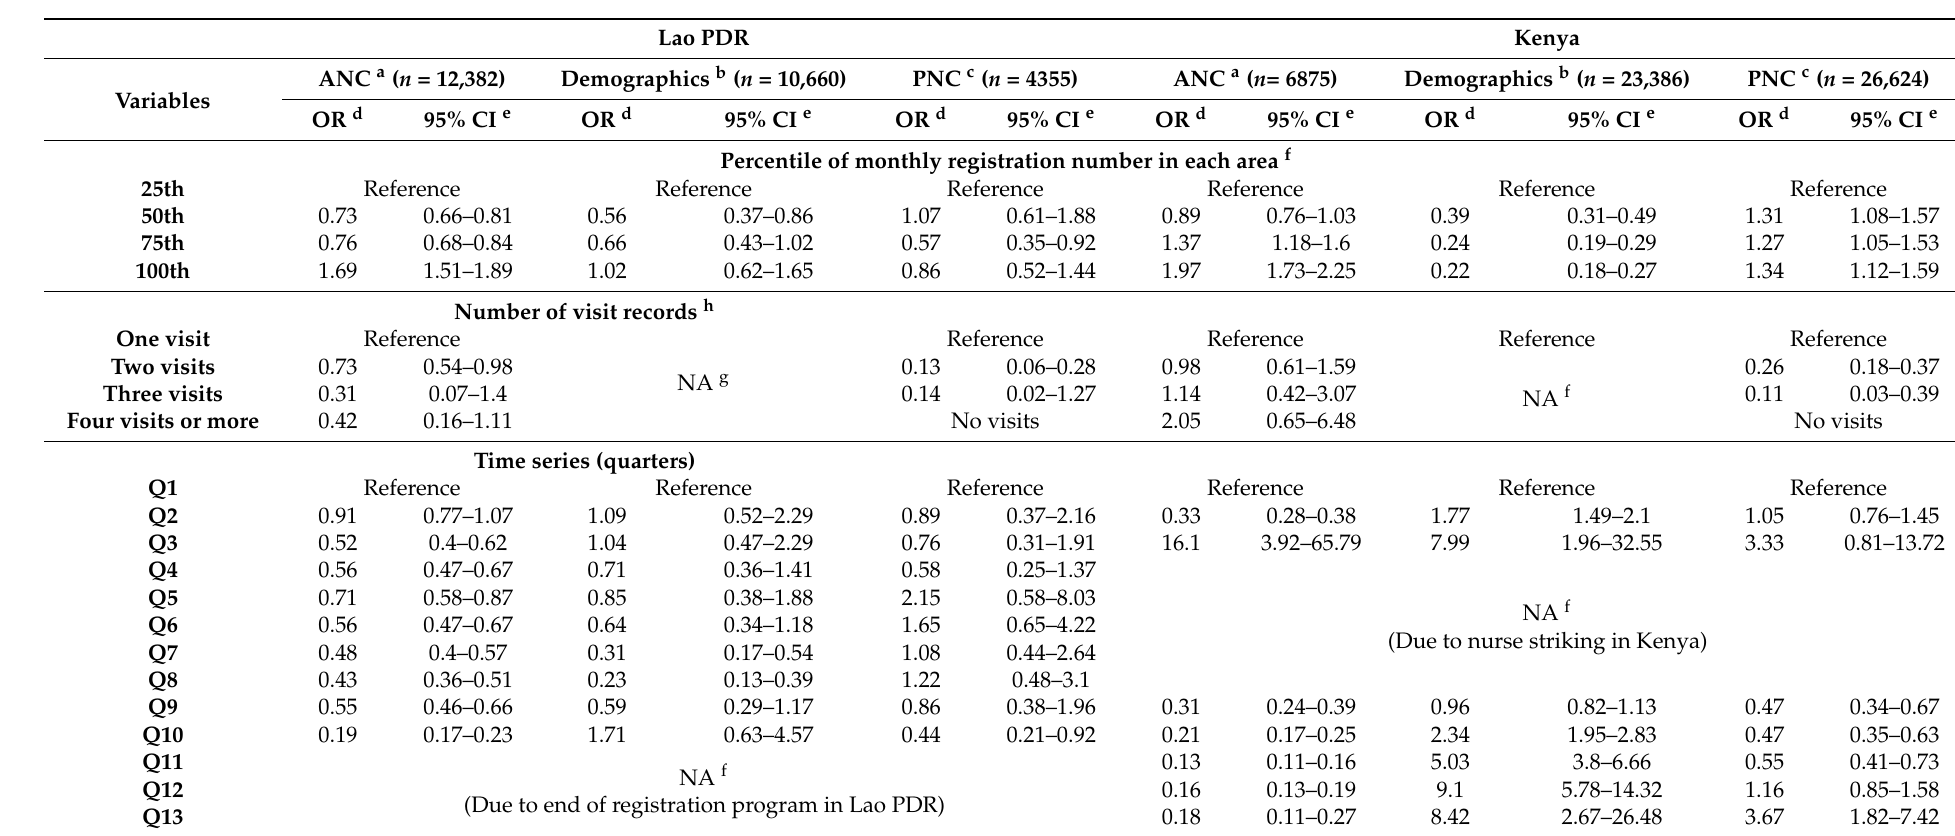
Table 3. Results of multivariate logistic regression analysis to percentile intervals in monthly registration numbers and number of visits analyses * to evaluate data entry quality in both study areas, Lao PDR, and